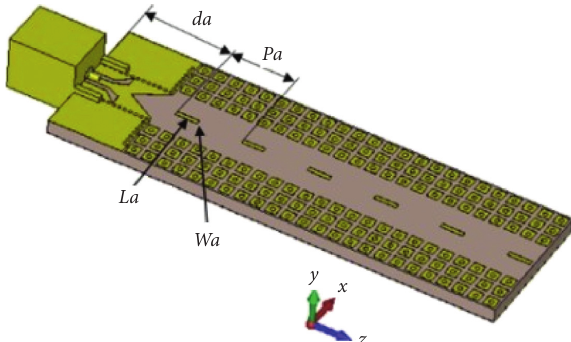
Figure 11: Configuration of the proposed Ku-band periodic leaky wave antenna array (La � 4, Wa � 0.8, Pa � 12, da � 13.4, unit: mm).